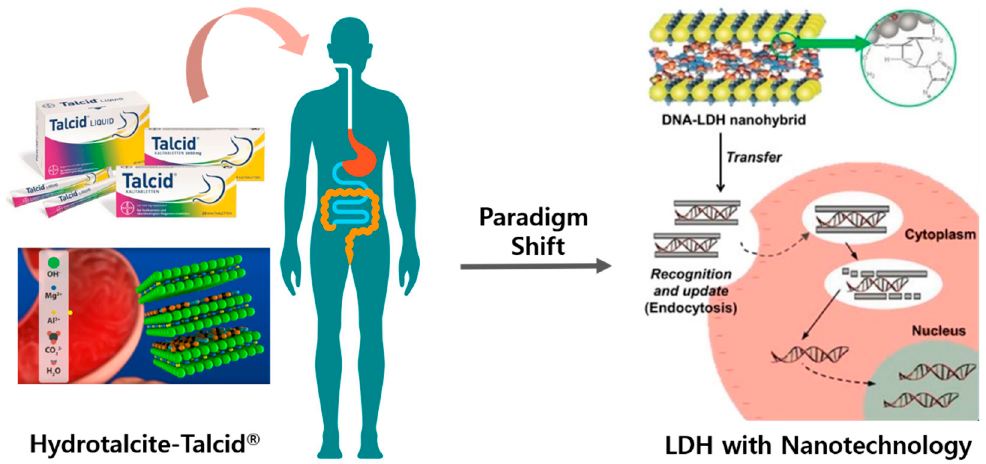
Figure 1. Schematic illustration of the paradigm shift from antacid and anti-pepsin agent, hydrotalcite-Talcid ® to emerging cellular delivery vector, layered double hydroxide (LDH) with nanotechnology, reproduced from [3,12,17]. Images in parts ‘hydrotalcite-Talcid ® ’ courtesy of Bayer, Germany and Gattefosse, France.